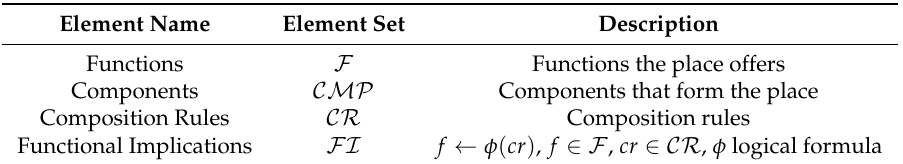
Table 1. Design pattern [7].